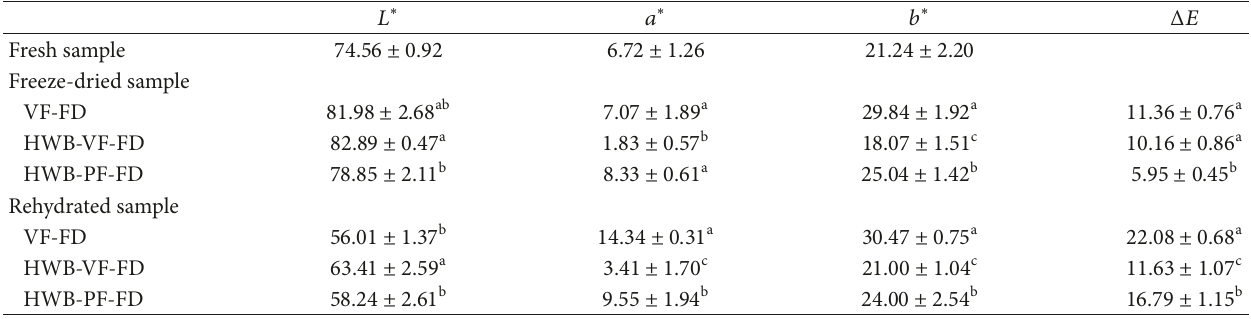
Table 1: Color difference of freeze-dried and rehydrated samples in 3 freeze-drying methods. 𝐿 ∗